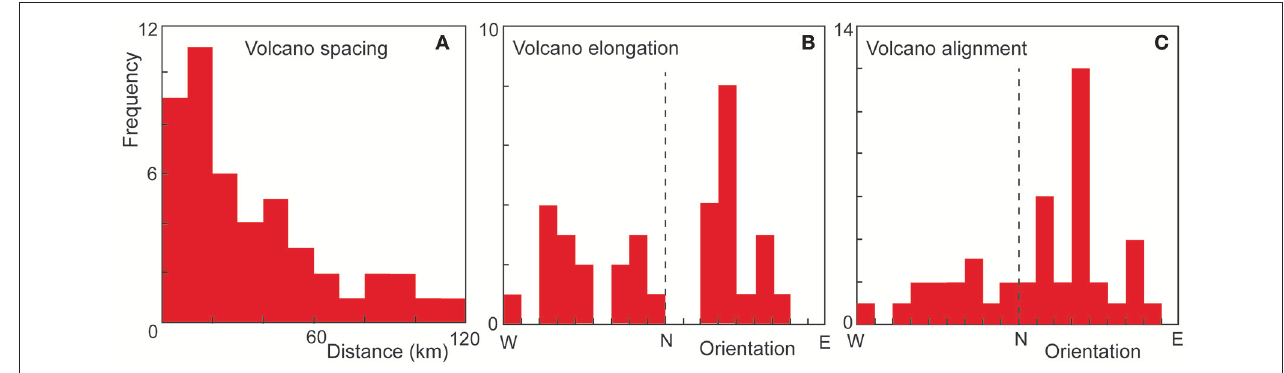
FIGURE 9 | Overview of the collected structural field data, along the central portion of the GSF, on lower hemisphere stereograms of fault slip data together with the inversion results characterizing stress regimes. Numbers at bottom right of stereograms refer to the sites where the structural data have been measured (location in the map). Letters at upper left of stereograms (from A to E ) are used as reference in the text. The used inversion method (e.g., Carey, 1979) assumes that the slip represented by the striation occurs in the direction of the resolved shear. Deviatoric principal stress axes: σ 1 , σ 2 , σ 3 , are the compressional, intermediate and extensional deviatoric axes, respectively. The age of the faulted formation is also reported. The exact location for the deviatoric principal stress axes could not be determined in (D) because of the relatively few (five) and clustered (four out the five) data.